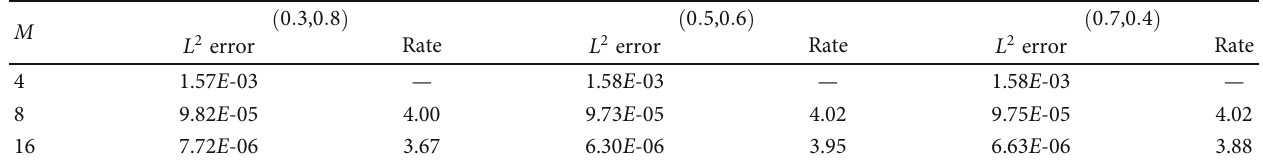
Table 3: The L 2 -norm errors in space for smooth case in Example 1 with τ = T /8000 . M